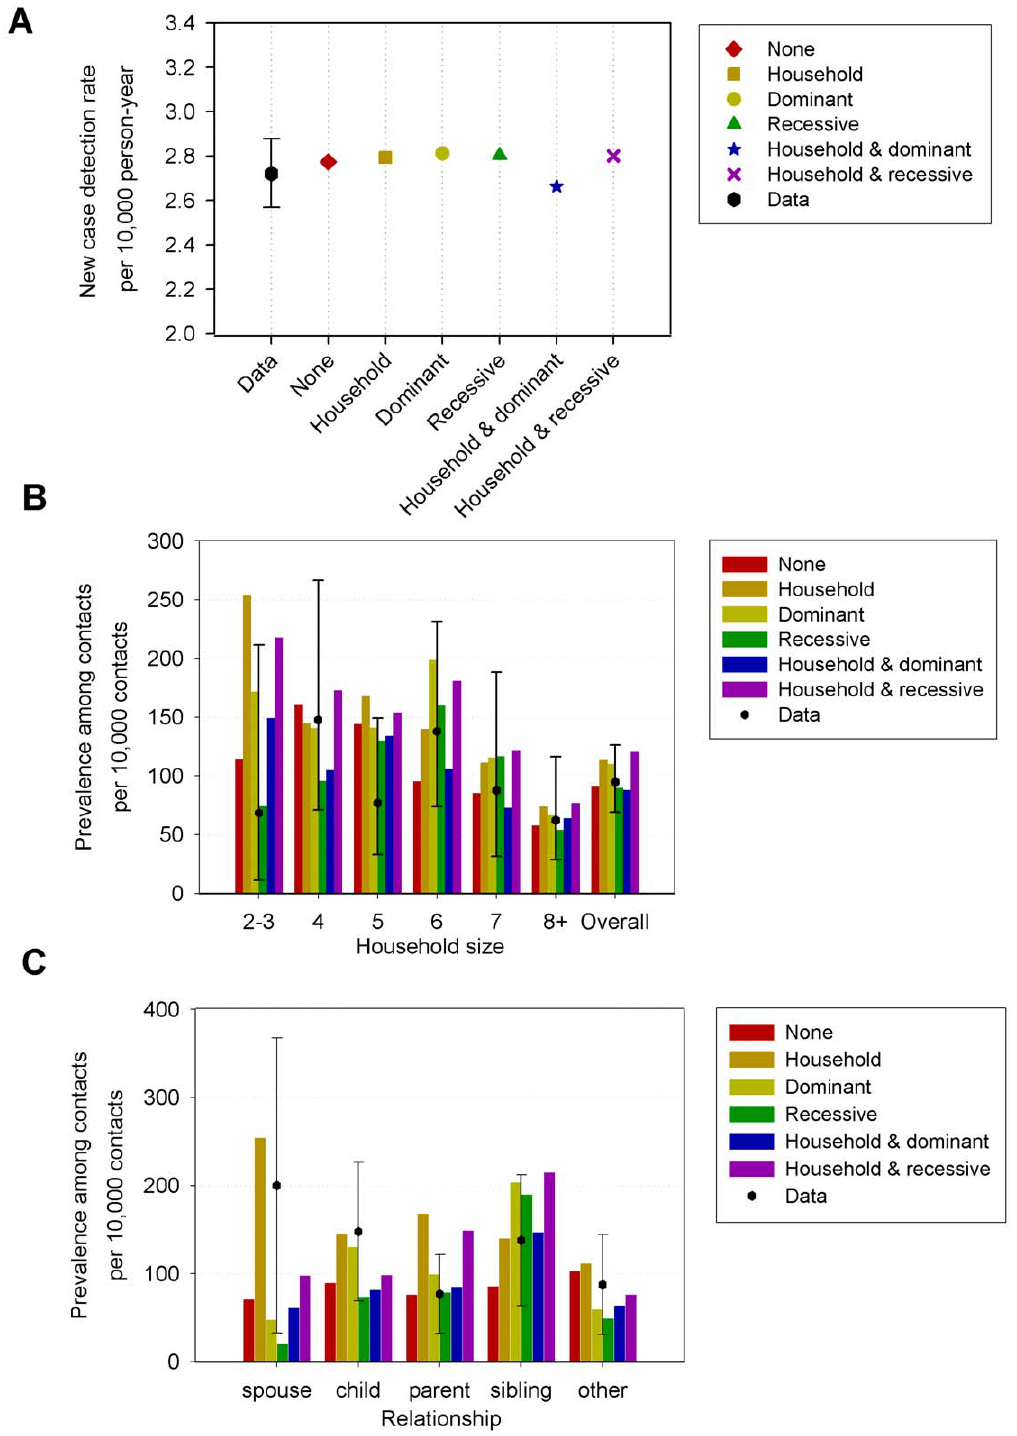
Figure 3. Comparison of model output with observations for six mechanisms of heterogeneity in leprosy susceptibility, assuming 10% susceptibles in the population. A value of 20% susceptibles provided a much better fit for the Random mechanism. (A) New case detection rate per 10,000 inhabitants. The observed detection rate in 2003 is shown on the left, with 95% confidence interval. In total 1,184 patients in a population of 4.3 million persons. (B) Prevalence of leprosy among previously undiagnosed contacts of leprosy patients by household size. (C) Prevalence of leprosy among previously undiagnosed contacts of leprosy patients by relationship to the index patient. For (B) and (C) were used 43 previously undiagnosed contacts in 1,034 households.